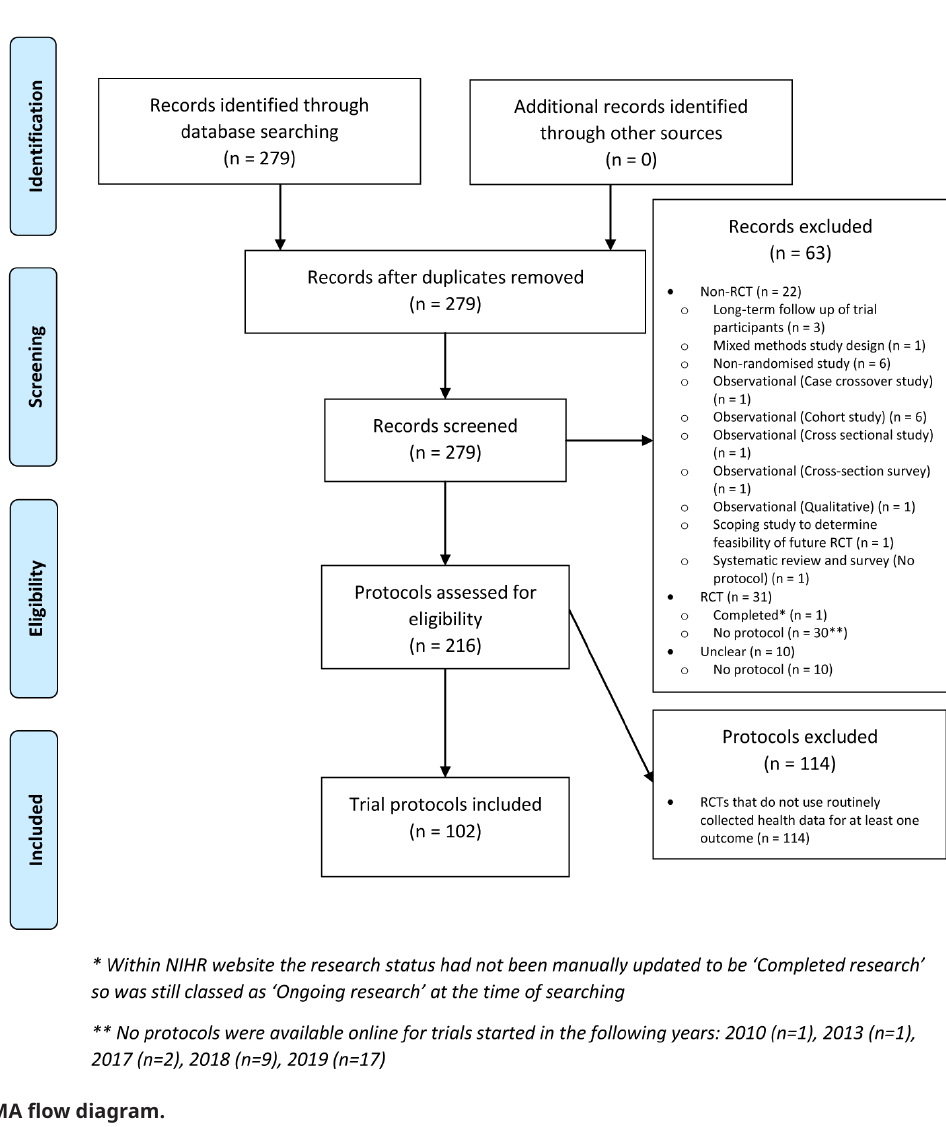
Figure 1. PRISMA flow